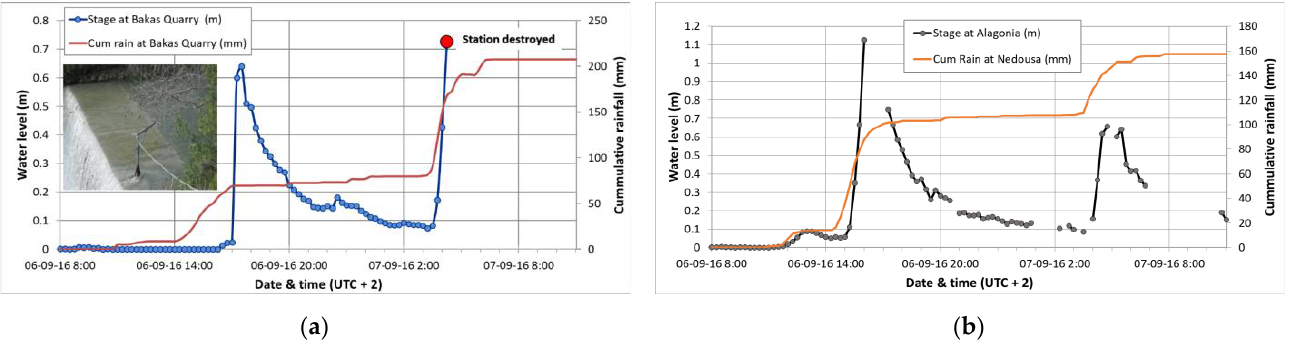
Figure 10. September 2016 flood at Baka’s Quarry station (inset) ( a ) and at Alagonia station ( b ).